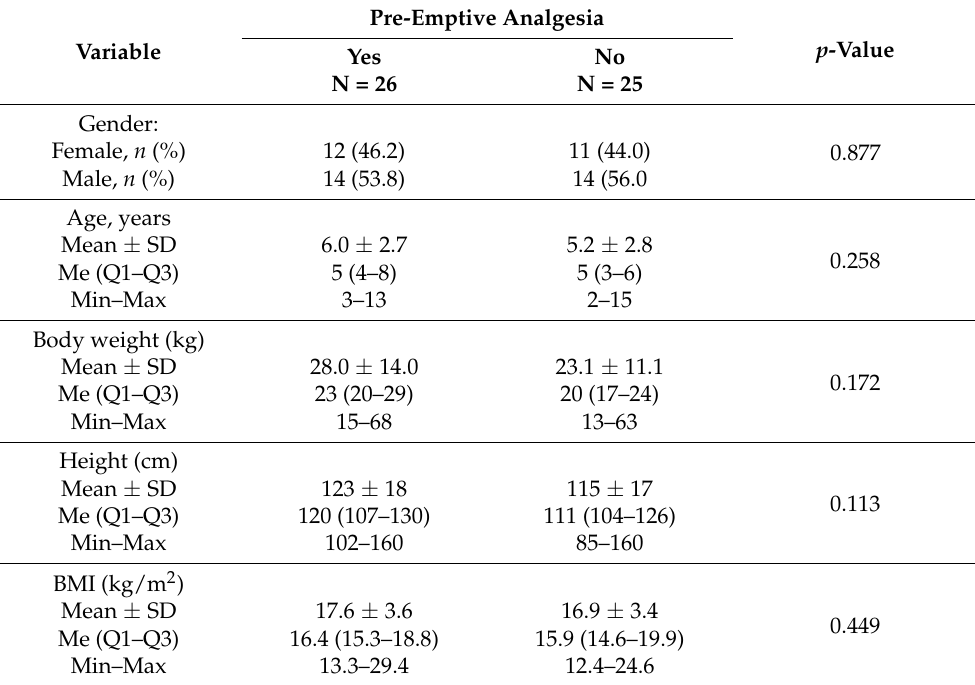
Table 2. Characteristics of children in groups that differ in pain